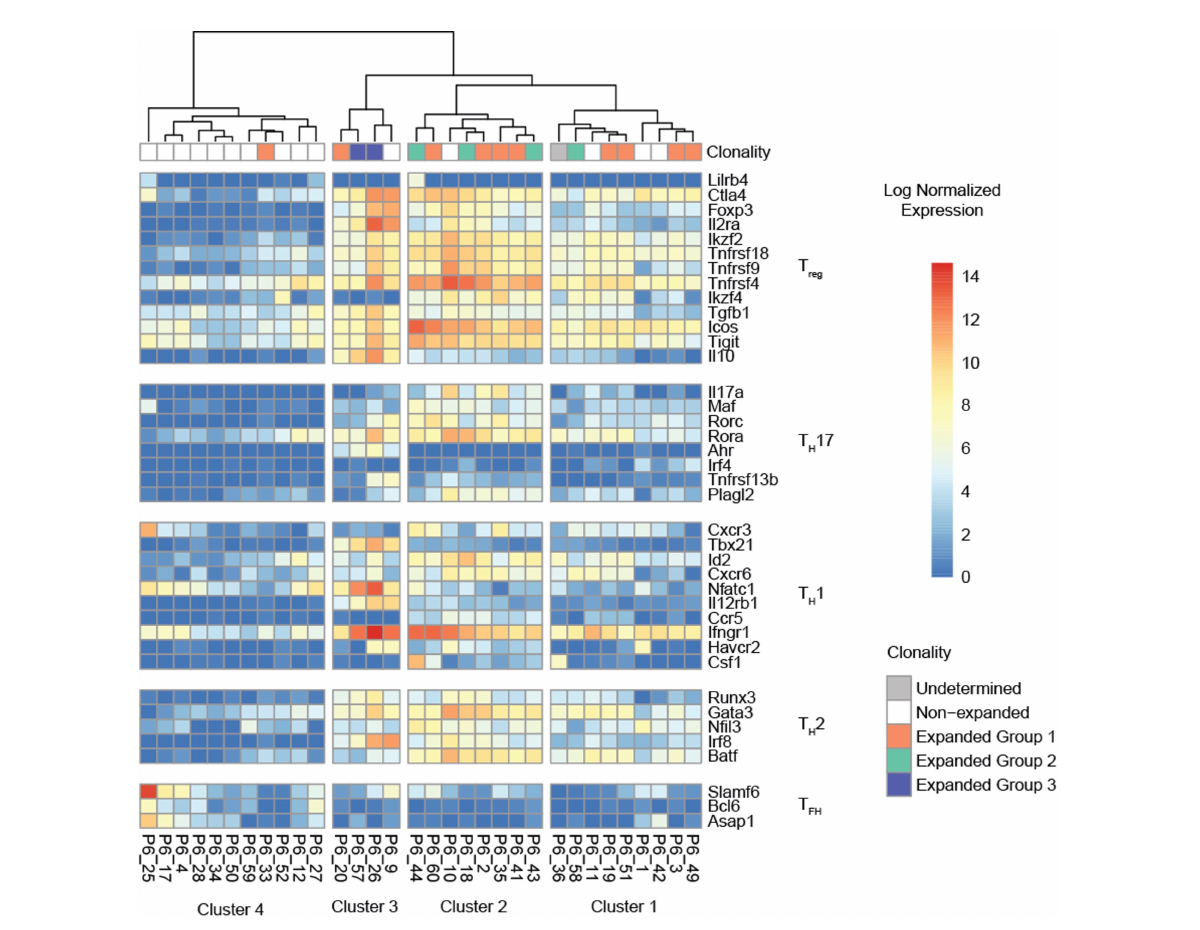
FIGURE4 Hierarchical clustering of the normalized expression heatmap of 38 lineage-defining genes across all P6 + cells. Columns were clustered according to Ward’s second clustering criterion. Four segments were automatically generated based on the hierarchical clustering. All clusters with expanded P6 + cells (clusters 1, 2, 3) show evidence of a T reg